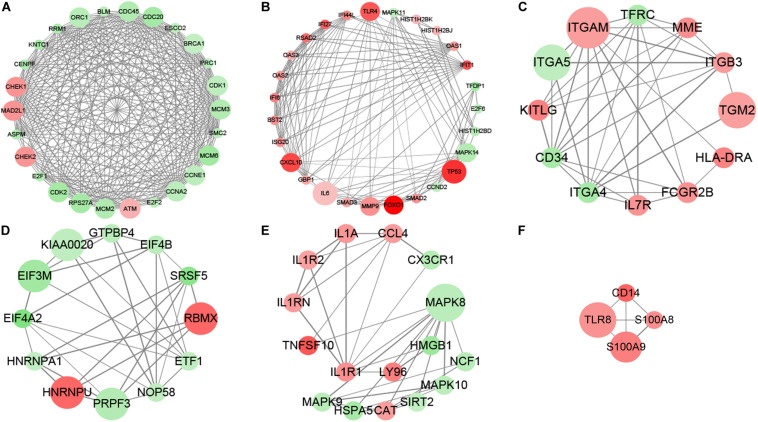
MCODE analysis. MCODE analysis based on the degree of importance, and six main subnetworks were displayed. Upregulated genes are marked in red; downregulated genes are marked in green. The size of dots represents the node degree. (A–F) Showed the six main subnetworks using